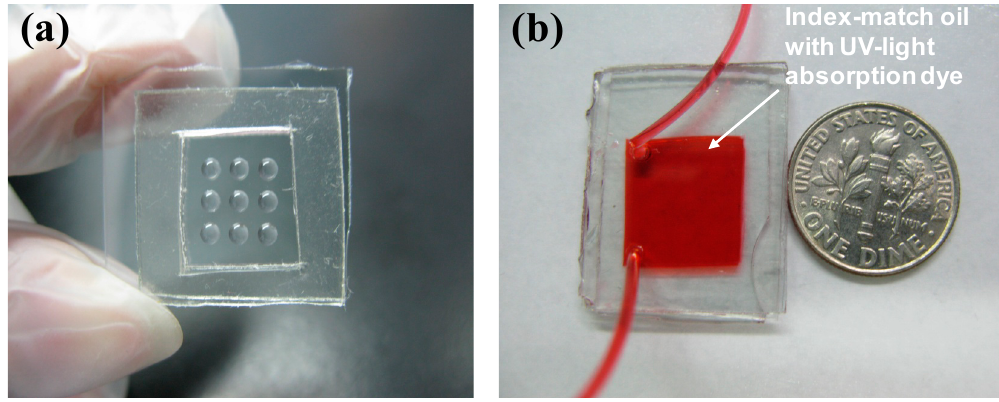
Figure 2. Images of the EFM-3D mask ( a ) before and ( b ) after filling with the index-matching oil (hexadecane) that contains UV-light absorption